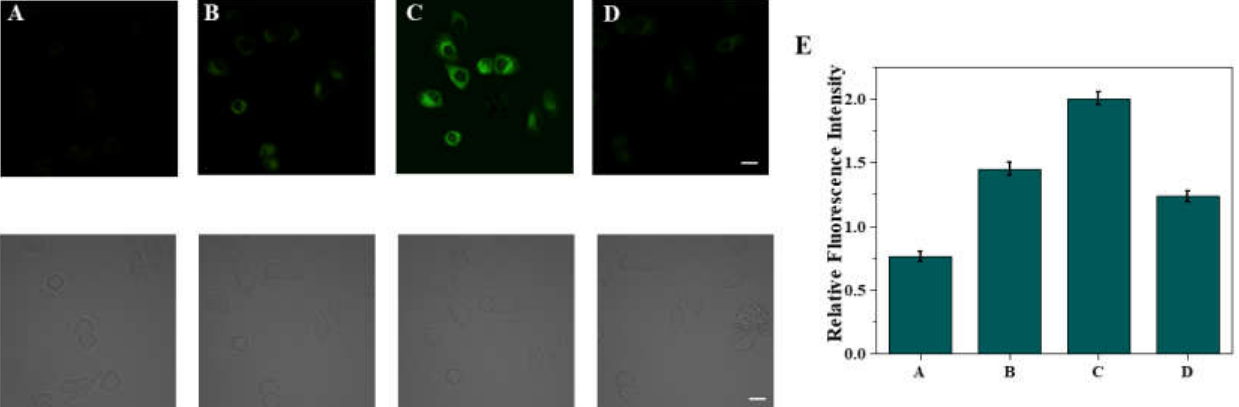
Figure 3. Confocal fluorescence imaging of HDBT-ONOO − with exogenous addition of ONOO − donor (SIN-1) in HeLa cells. HeLa cells were incubated with HDBT-ONOO − (10 µ M) and ( A ) 0, ( B ) 0.5, ( C ) 1.2 mM SIN-1, and ( D ) 200 µ M ebselen, and 1.2 mM SIN-1. ( E ) Relative fluorescence intensity of ( A – D ). Cells were stained with HDBT-ONOO − (10 µ M) for 30 min, washed with PBS, and imaged by confocal microscopy. λ ex = 880 nm, scale bar: 30 µ m. Error bars represent the standard deviations of three separate measurements (n = 3).